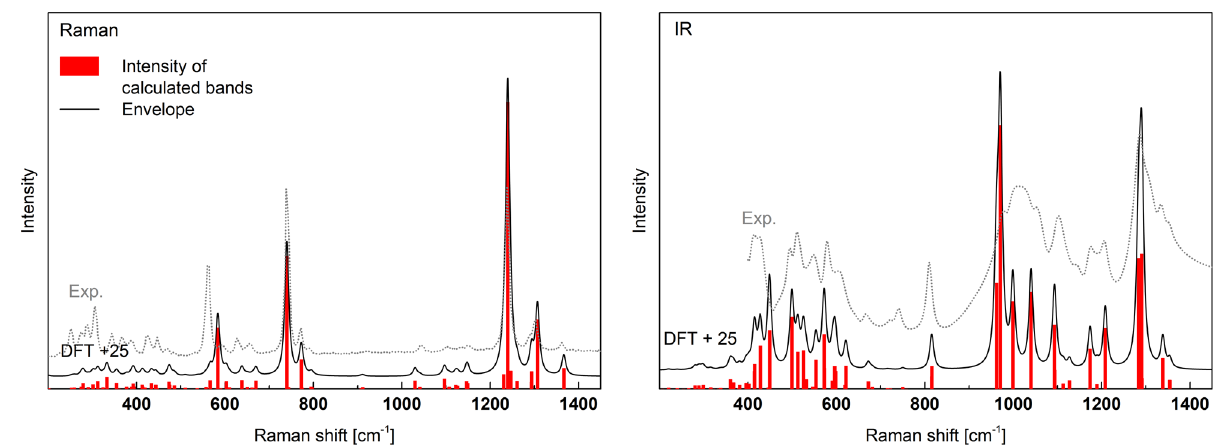
Figure 10. Calculated Raman and IR spectra of aluminum cyclohexaphosphate -Al(PO 3 ) 3 shifted by + 25 cm −1 and experimental IR and Raman spectra (Exp.) of the synthesized